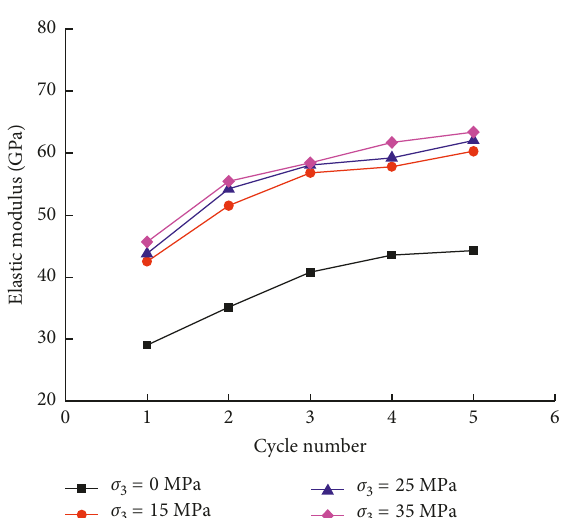
Figure 7: Variations of elastic modulus with cycle number under different confining pressures.